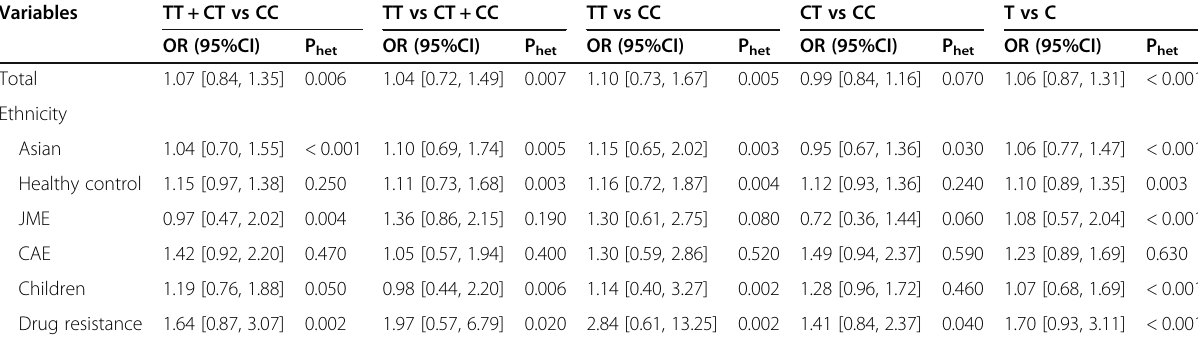
Table 2 Stratified analysis of GABRG2 rs211037 polymorphism on IGE